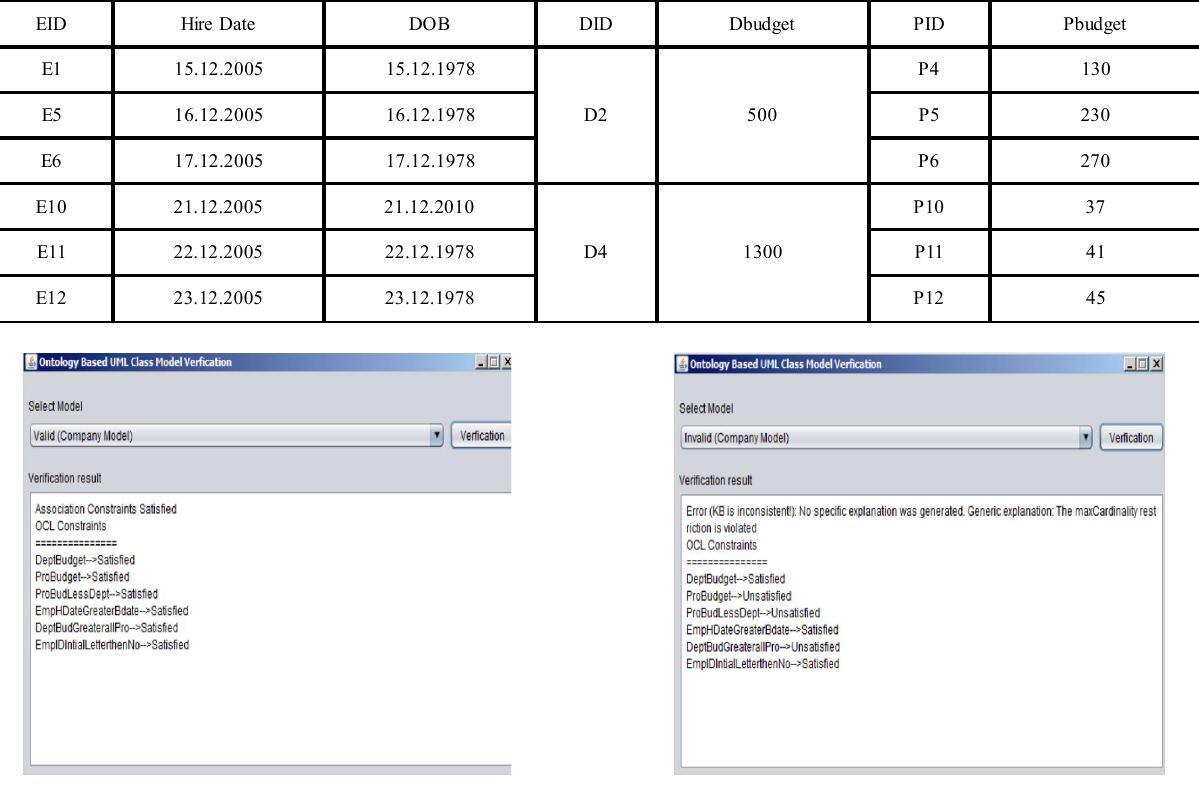
FIG. 5. VERIFICATION